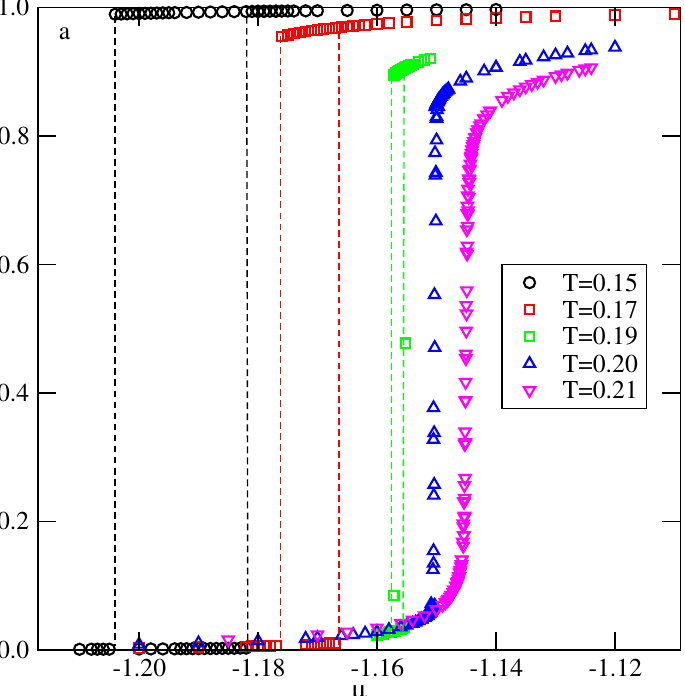
Figure 2. The examples of isotherms recorded for the system with u ∗ = − 0.1 at different temperatures (given in the